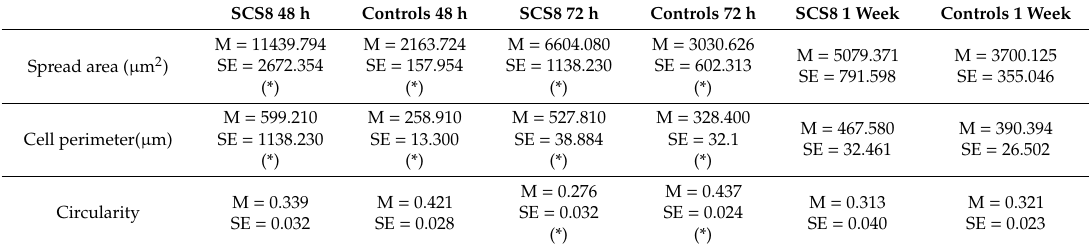
Figure 16. Shape variables. ( A ) Quantification of cellular spread area, ( B ) Quantification of cellular perimeter, ( C ) Quantification of cellular circularity, ( D ) Quantification of cellular roundness, ( E ) Quantification of cellular aspect. Data quantified in Image J (*); p < 0.05. Table 6. Shape parameters by time and group. Statistically significant di ff erences are labeled with an asterisk (*), p < 0.05. (M = mean and SE = standard error). SCS8 48 h Controls 48 h SCS8 72 h Controls 72 h SCS8 1 Week Controls 1